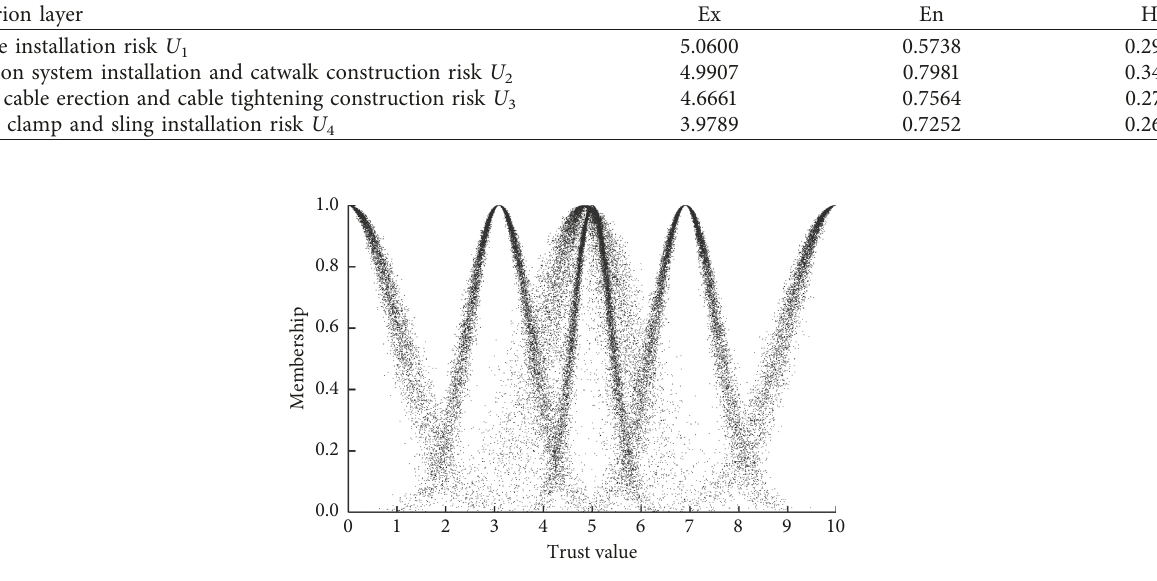
Figure 5: Diagram of the risk reliance cloud and criterion reliance cloud of each risk Table 5: Similarity between criterion reliance cloud of each risk level and risk reliance cloud.